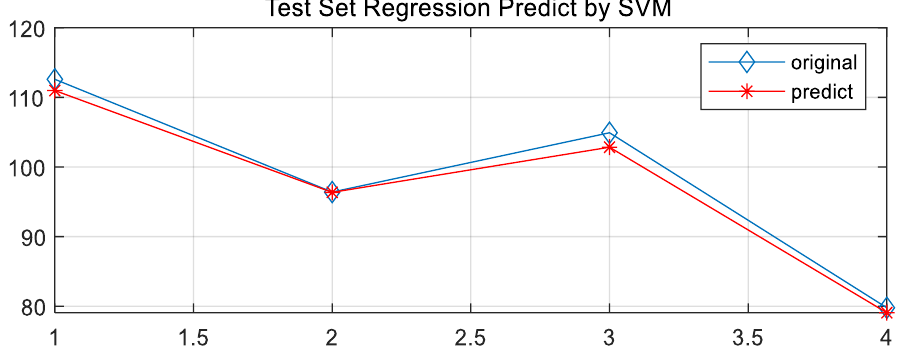
Figure 12. GA-cg parameter optimization fitness curve. Figure 13. GA(cg)-SVM test set data fit.